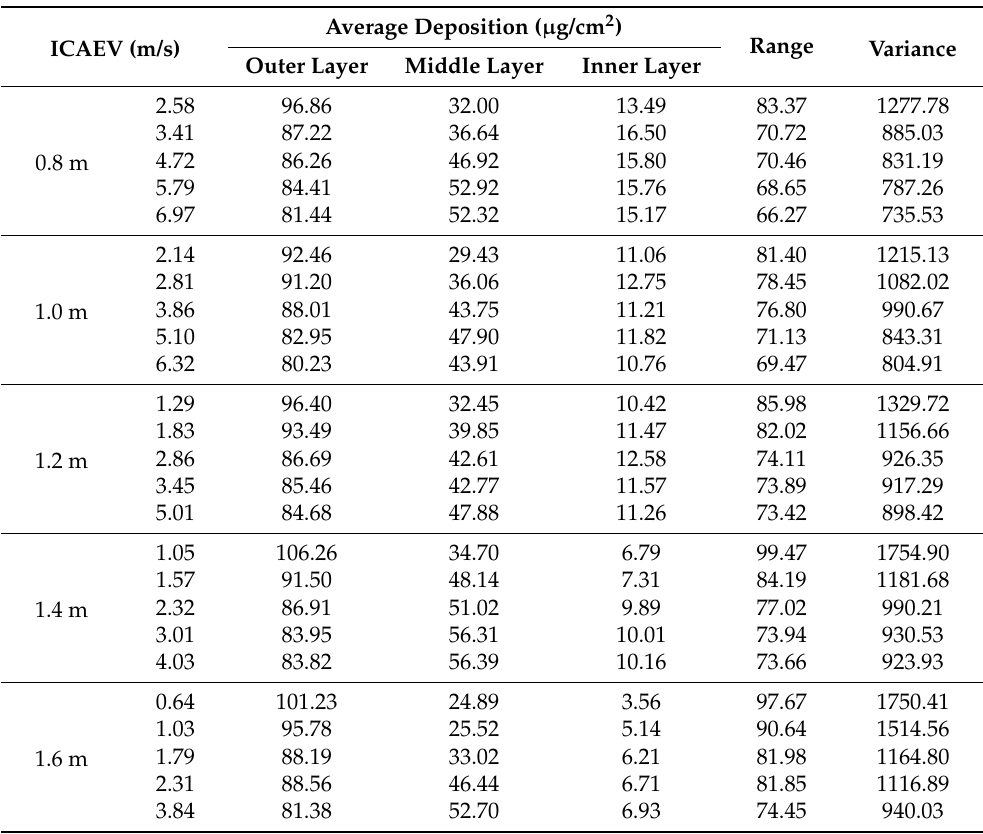
Table 2. Distribution of spray droplet deposition in the